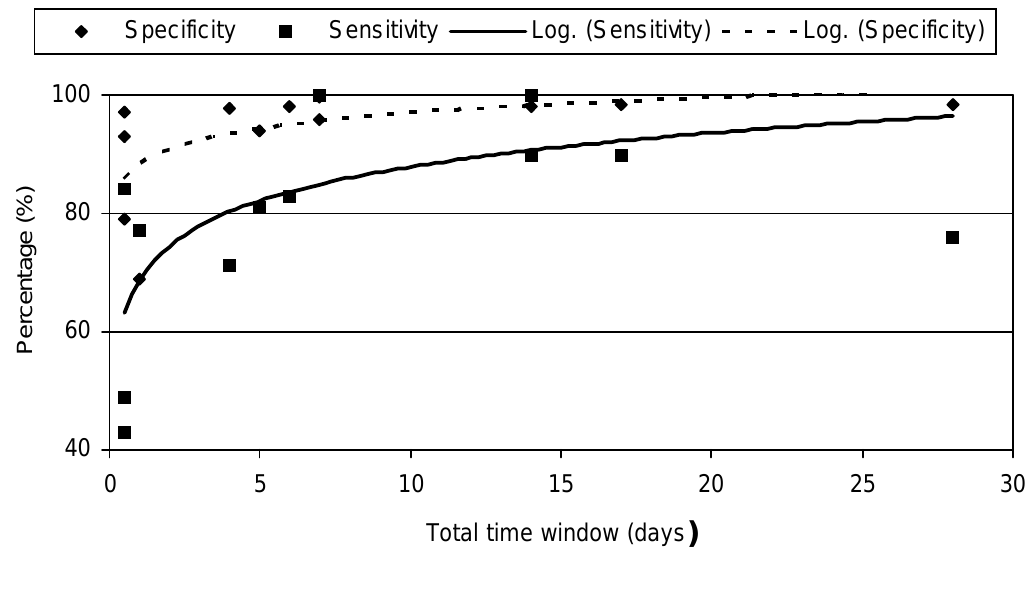
Figure 2 . Sensitivities and specificities (y-axis) of various studies, plotted against the used time windows (x-axis). Given are the observations and a logarithmic